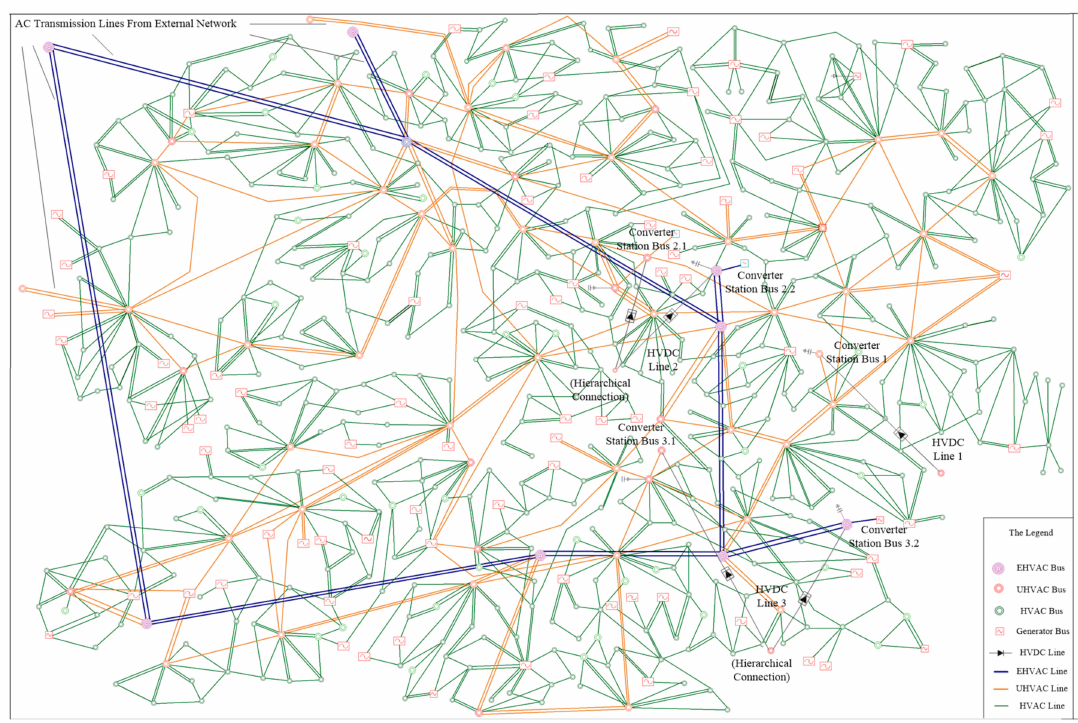
Figure 6. Network structure of the test